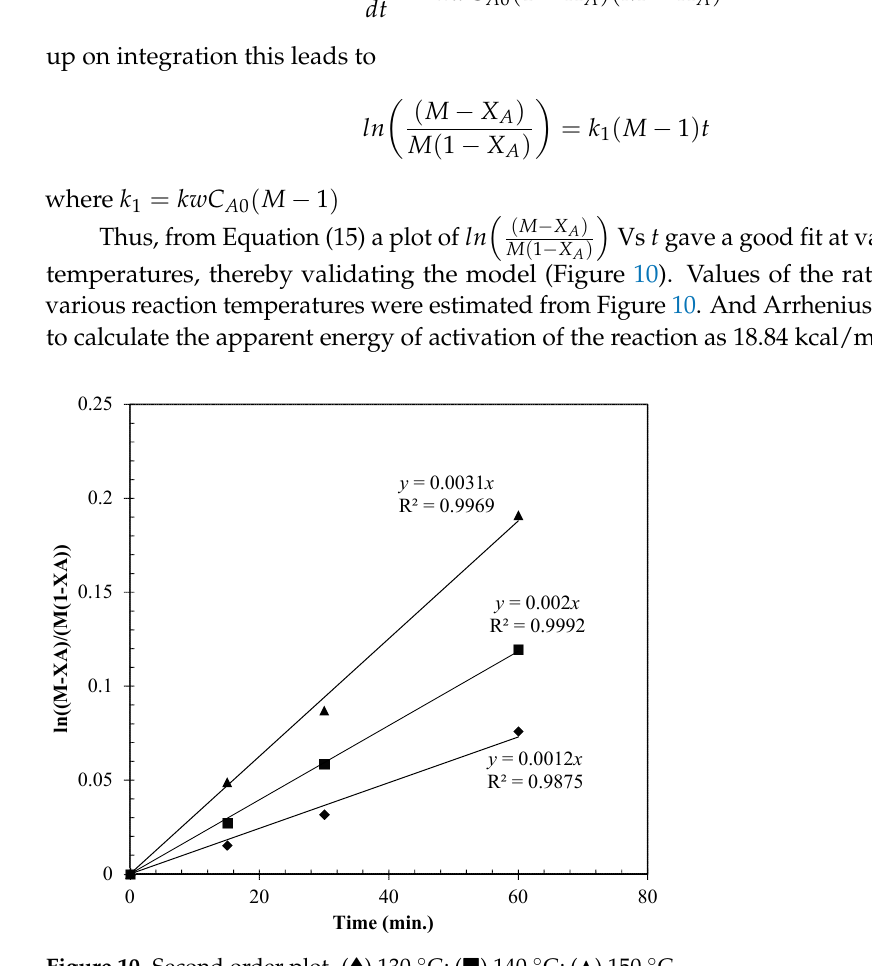
Figure 10. Second order plot. ( (cid:7) ) 130 ◦ C; ( (cid:4) ) 140 ◦ C; ( (cid:78) ) 150 ◦ C.